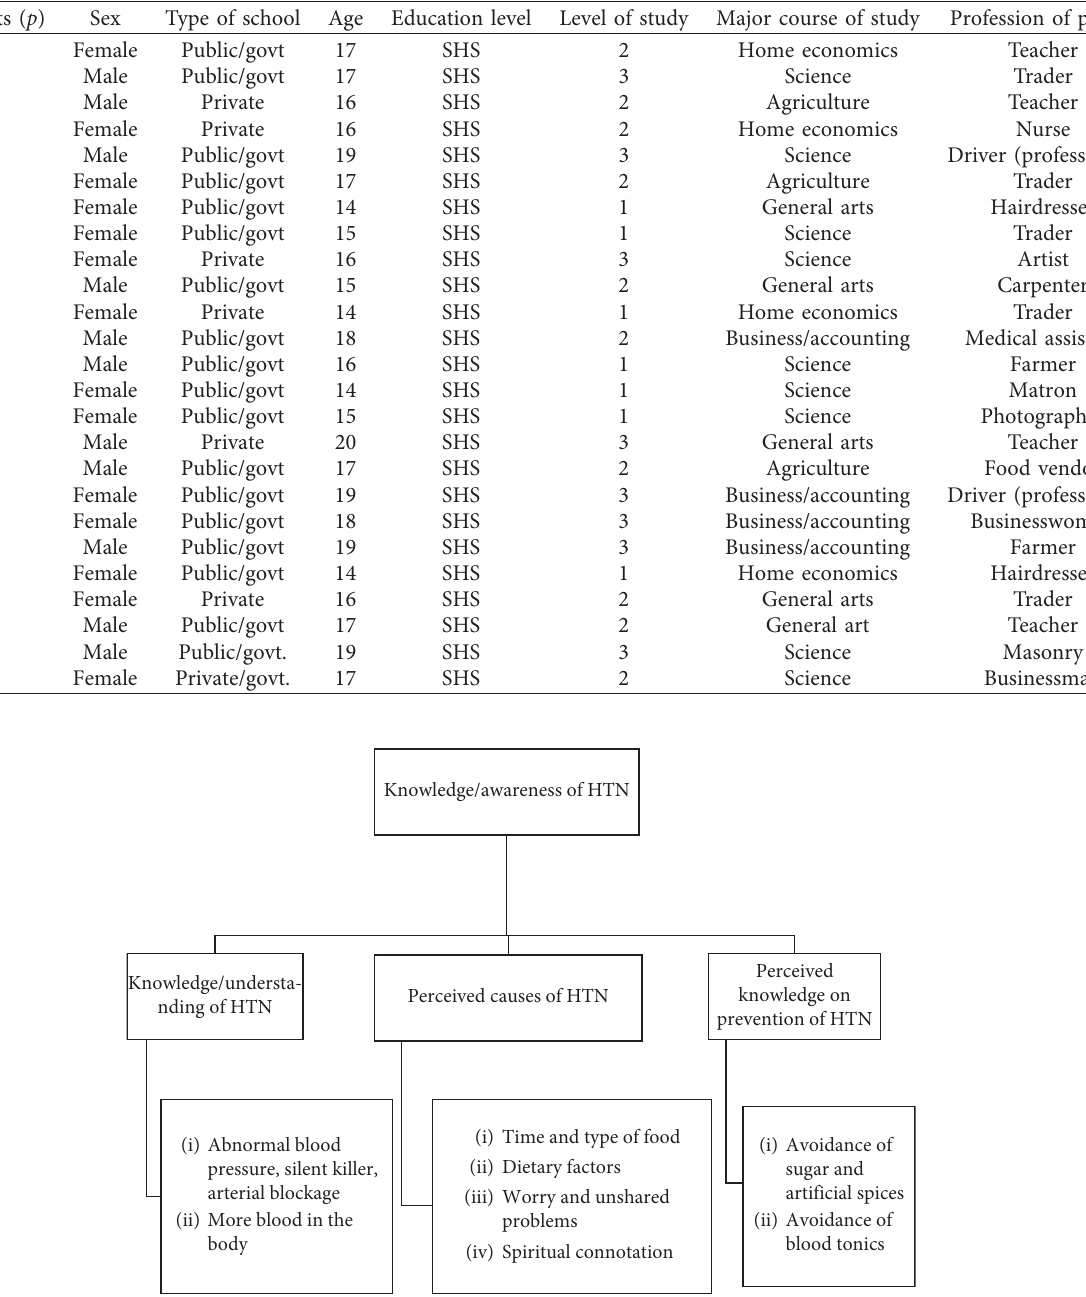
Figure 1: Underlying themes and subthemes.